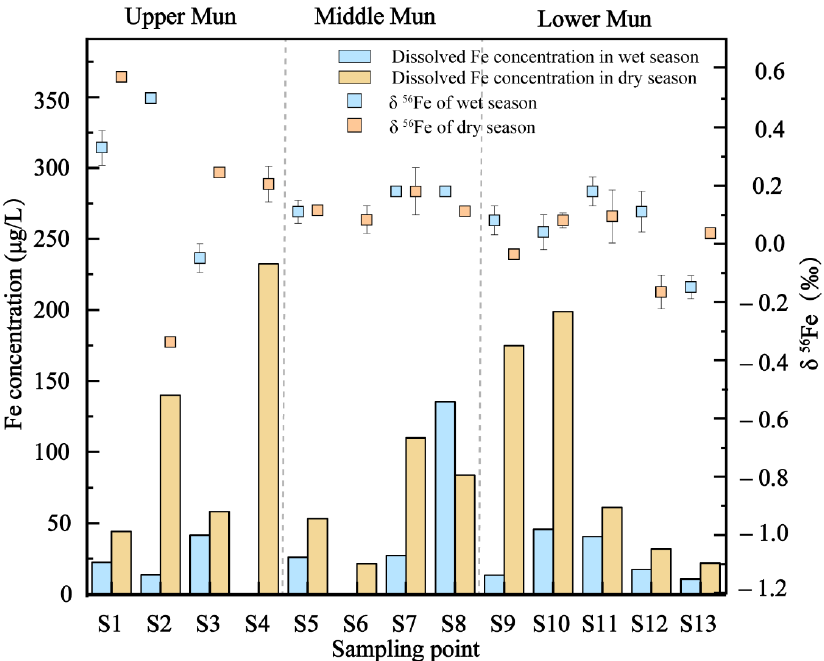
Figure 3. The concentration of dissolved Fe in MR during dry and wet seasons and the δ 56 Fe of the dry and wet seasons. The δ 56 Fe data of the wet season are from [40] and data of Fe concentration are from [30] .